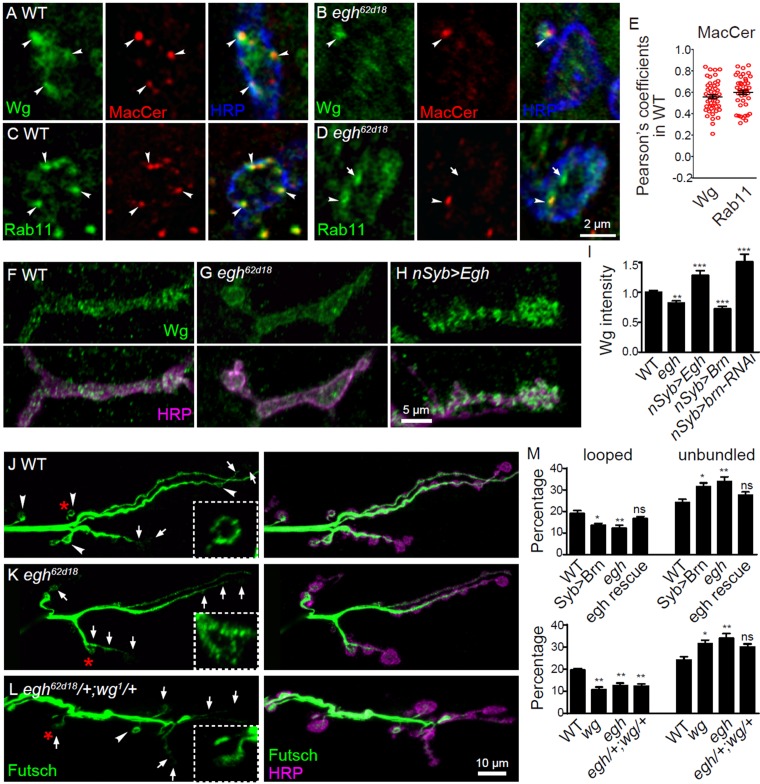
MacCer is required for the local presynaptic Wg signaling at NMJs.(A–D) Confocal images of single slice of NMJ4 boutons triple-labeled with anti-MacCer (red), anti-HRP (blue) and anti-Wg (green; A–B) or anti-Rab11 (green; C–D) in wild type and egh62d18 mutants. MacCer puncta showed substantial colocalization (arrowheads) with Wg and Rab11 in boutons. Arrows indicate Rab11-positive puncta without MacCer staining in the egh62d18 mutants. Images were processed by deconvolution. Scale bar: 2 μm. (E) Pearson’s coefficients of colocalization between MacCer and indicated proteins. n = 51 and 44 boutons (from ten wild-type larvae each) for colocalization of MacCer with Wg and Rab11, respectively. (F–H) Representative images of NMJ4 co-labeled with anti-Wg (green) and anti-HRP (magenta) in wild type (F), egh62d18 mutants (G) and UAS-Egh/+; nSyb-Gal4/+(H). Scale bar: 5 μm. (I) Quantification of intensities of endogenous Wg normalized to HRP intensities in different genotypes. n ≥ 15 larvae; ns, no significance; **p<0.01 and ***p<0.001 by student’s t test; error bars: s.e.m. (J–L) Representative images of NMJ6/7 labeled with anti-Futsch (green) and anti-HRP (magenta) in wild type (J), egh62d18 mutants (K) and egh62d18/+; wg1/+transheterozygotes (L). Insets show higher magnification images of Futsch staining of a single bouton (asterisk). Arrows indicate boutons displaying unbundled Futsch; arrowheads denote boutons with Futsch loops. Scale bar: 10 μm. (M) Quantifications of percentage of Futsch loops and unbundled Futsch staining in different genotypes. The genotype of egh rescue was egh62d18; UAS-Egh/+; nSyb-Gal4/+; the genotype of wg was wg1/wgCX4. n ≥ 12 larvae; ns, no significance, *p<0.05; **p<0.01 by one-way ANOVA with Tukey post hoc tests, error bars: s.e.m.10.7554/eLife.38183.022Figure 6—source data 1.Numerical data for the statistical graphs.